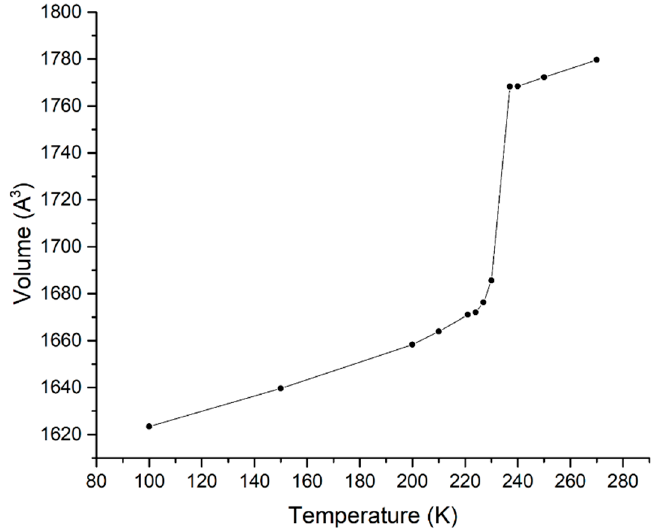
Figure 2. The dependence of unit cell volume on temperature.